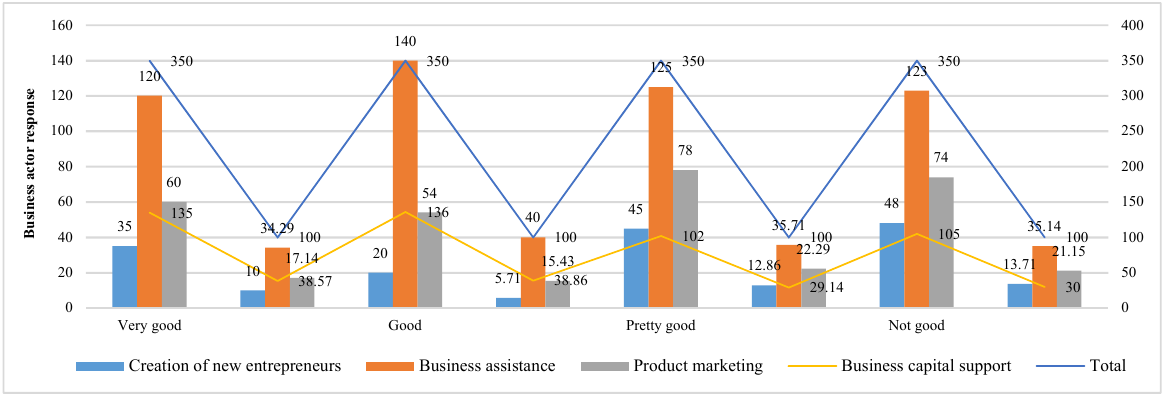
Figure 4. Respondents’ perceptions of the role and support of government policies in the development of SMEs. Source: primary data.